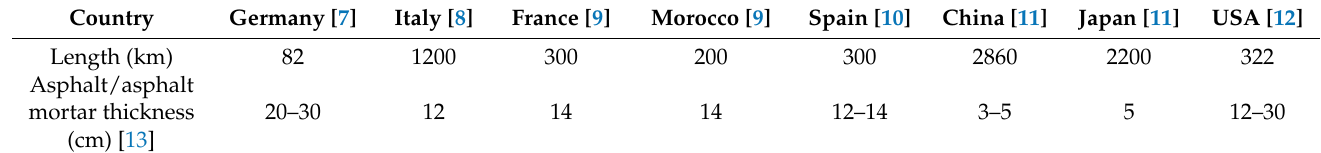
Table 1. Lengths and thicknesses of railway tracks with bituminous layers in various